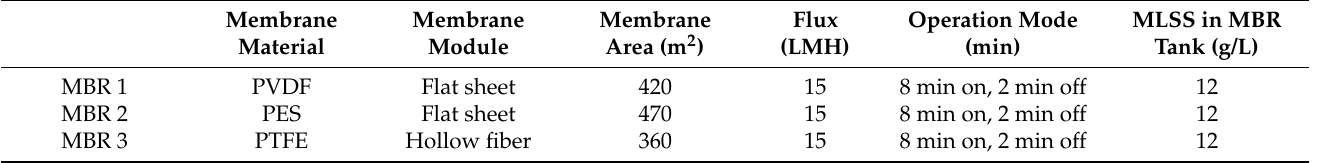
Table 2. Parameters of the membrane modules and the corresponding MBRs.